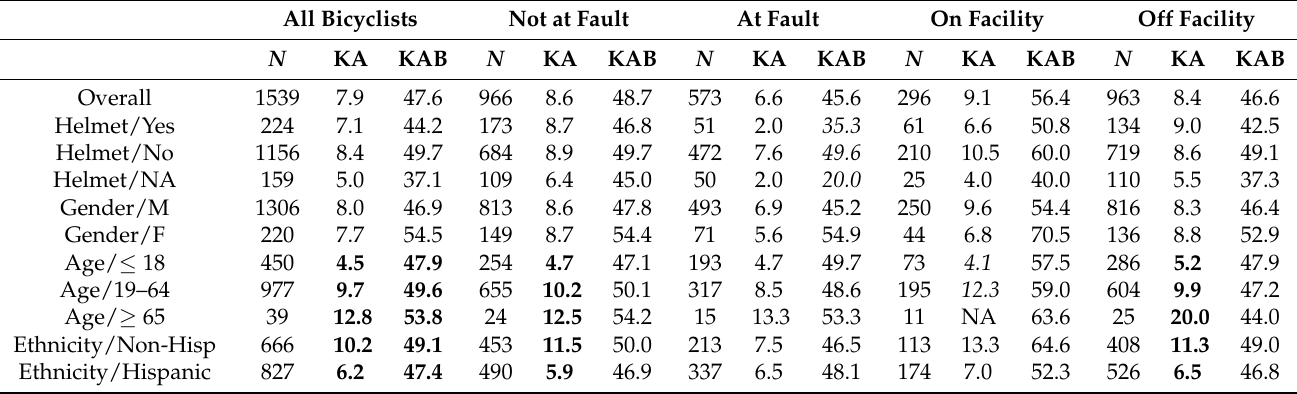
Table 3. Proportions of bicyclist KA and KAB crashes in San Antonio from 2014–2018 corresponding to bicyclist-related variables. All Bicyclists Not at Fault At Fault On Facility Off